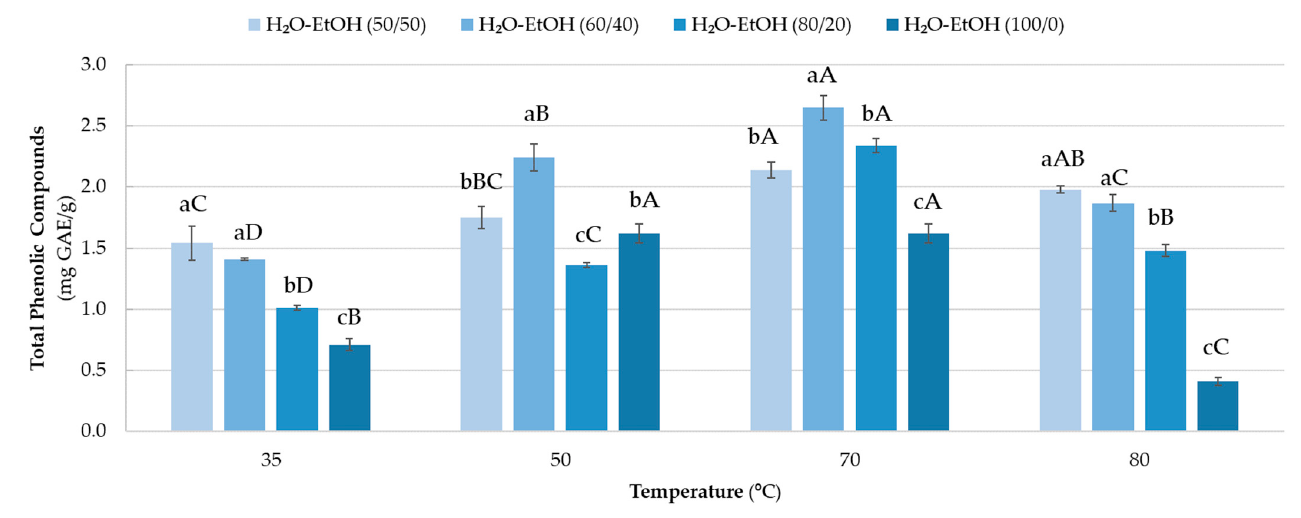
Figure 3. Total phenolic compounds in the different extracts according to the type of solvent and extraction temperature. For the same temperature, bars with the same lower letter are not statistically different (ANOVA with Tukey post hoc test, level of significance p < 0.05). For the same extracting solution, bars with the same capital letter are not statistically different (ANOVA with Tukey post hoc test, level of significance p < 0.05).